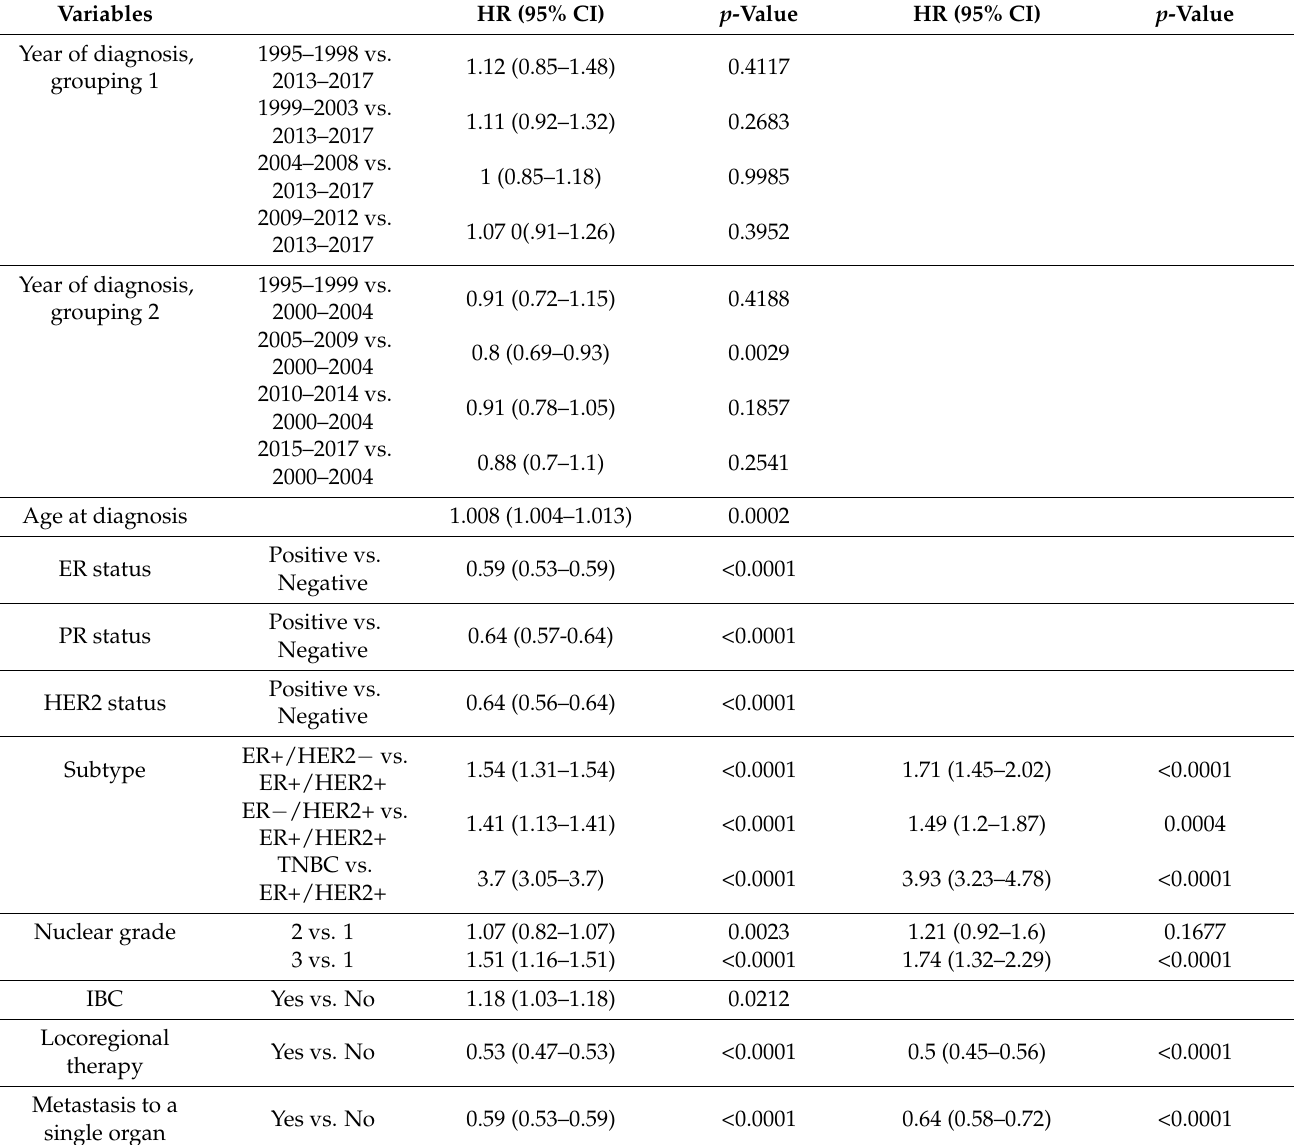
Table 2. Results of univariate and multivariate analysis for overall